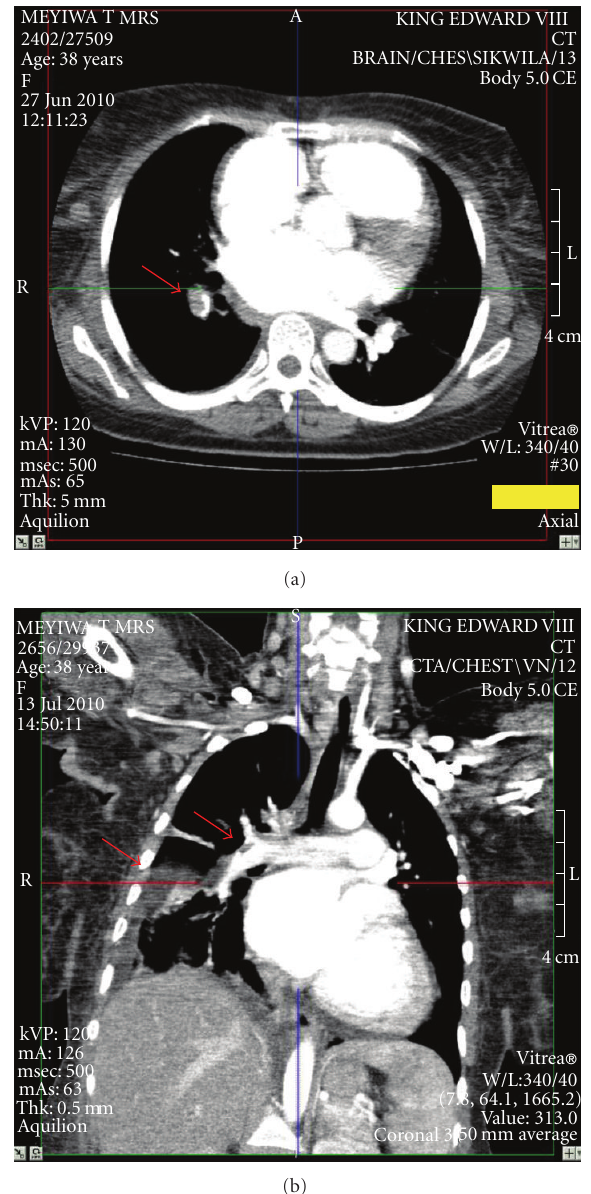
Figure 1: (a) Axial computerised tomography pulmonary angiogram showing filling defect in pulmonary artery. Similar filling defects were found at multiple levels of the pulmonary artery vasculature. (b) Coronal computerised tomography pulmonary angiogram showing multiple filling defects in the pulmonary artery and a triangular hypodensity in the right lower lung, which is most likely a pulmonary